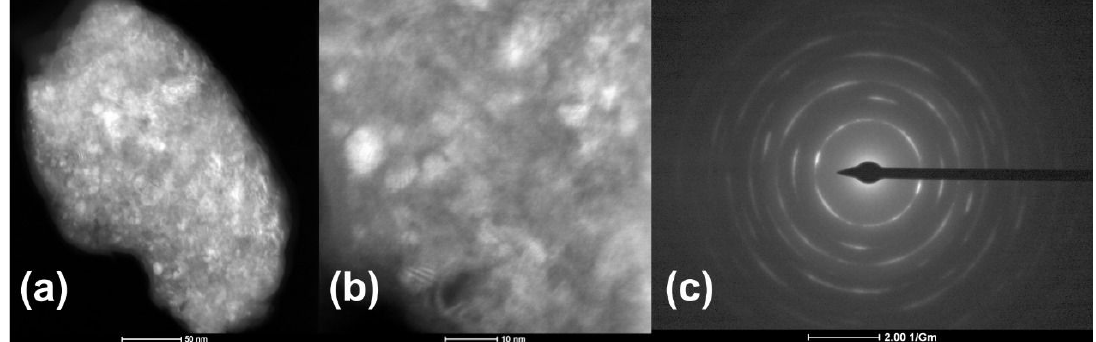
Figure 3. TEM observation of the cold-rolled TiFe IMC alloy: (a) dark-field image of an individual nanometer-sized particle; (b) grain size of ‘a’ shown at higher magnification, (c) corresponding the SAED pattern ([110], [200], and [211]).